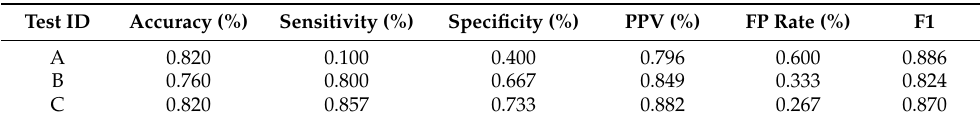
Table 8. Summary of automatically generated decision tree metrics for combined LIDC-IDRI and JSRT images.